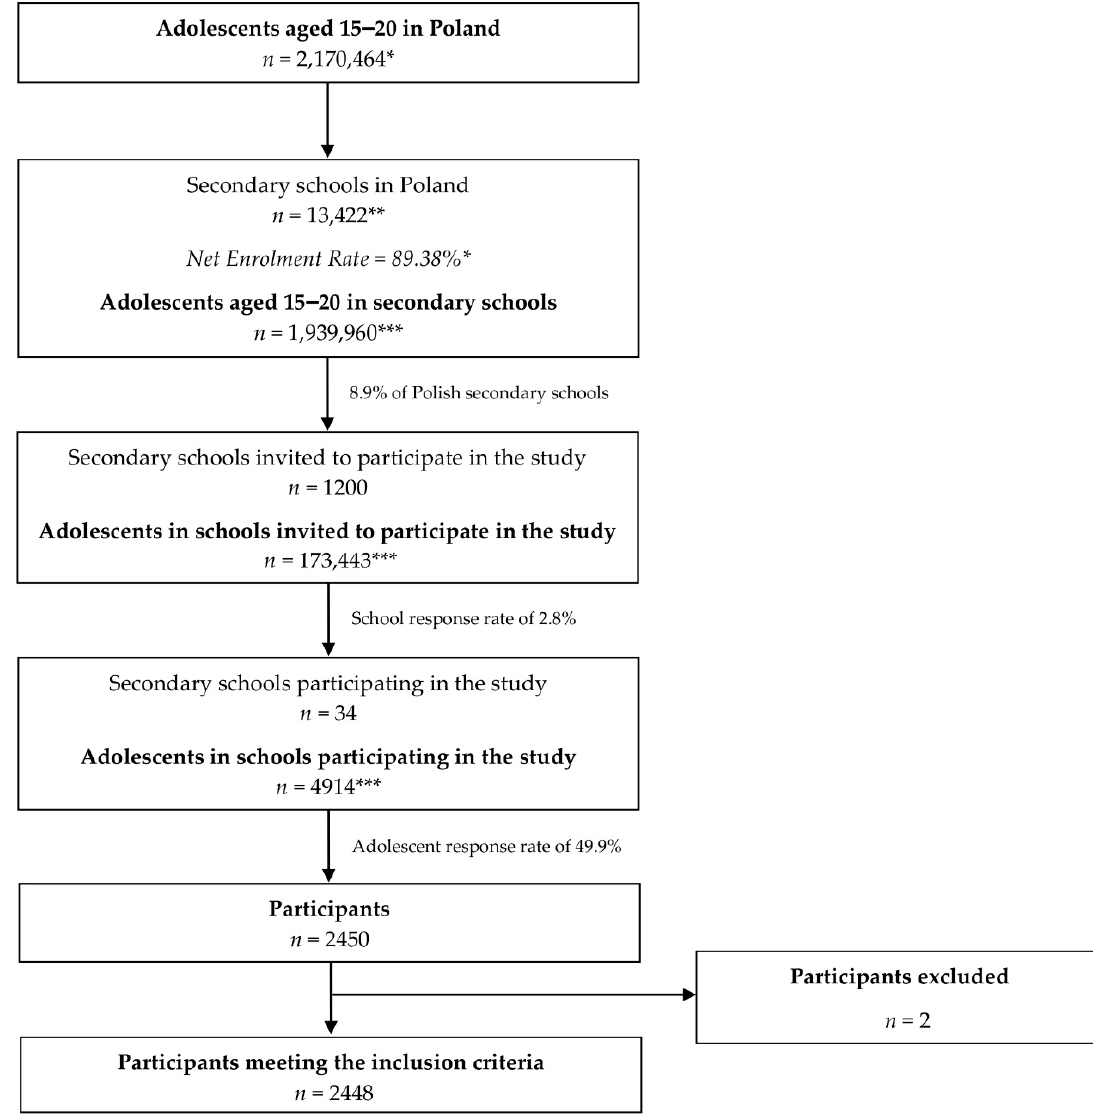
Figure 1. The procedure of secondary school sampling and students including to the PLACE-19 Study. * data by the Central Statistical Office (CSO) in Poland [26,32]; ** data by the Polish Ministry of National Education [33]; *** on the basis of the data by CSO.